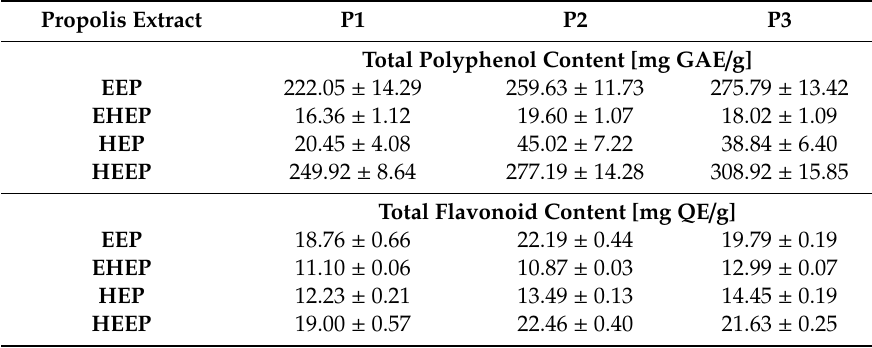
Table 2. Total polyphenol content and total flavonoid content of the prepared extracts; the results are expressed as mean ± SD; P1—propolis from Podlasie, P2—propolis from Masovia, P3—propolis from West Pomerania Province, EEP—ethanol extract of propolis, EHEP—ethanol-hexane extracts